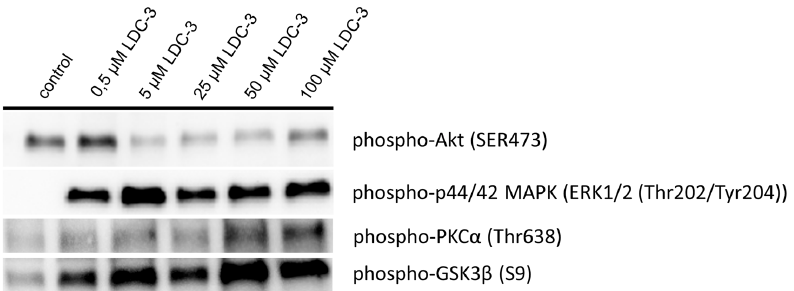
Figure 1. Immunoblotting of p42/p44-mitogen activated protein kinase (MAPK), Akt and cyclin-dependent kinase 1 (CDK1) activity. HaCaT cells were treated with increased dose of LDC-3 ( n = 3). The activation status of p42/p44-MAPK, Akt, protein kinase C α (PKC α ) and glycogensynthase kinase 3 β (GSK3 β ) were evaluated using specific antibody raised against activating phosphotyrosine/phosphothreonine residues (p42/p44-MAPK), activating phosphoserine residue (Akt), activating